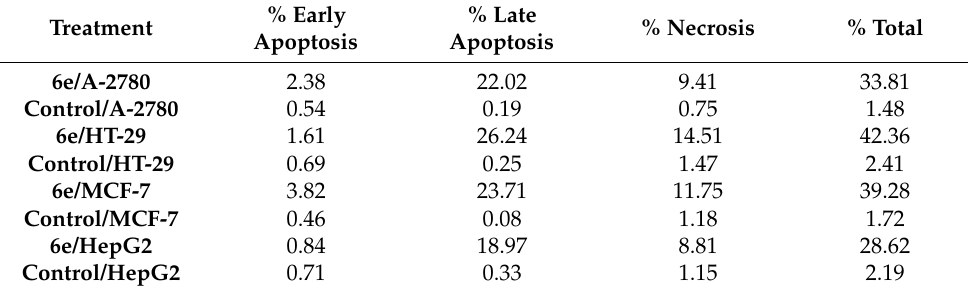
Table 4. Distribution of apoptotic cells in the Annexin V-FITC/PI dual staining assay in A-2780, HT-29, MCF-7, and HepG2 cells after treatment with 6e